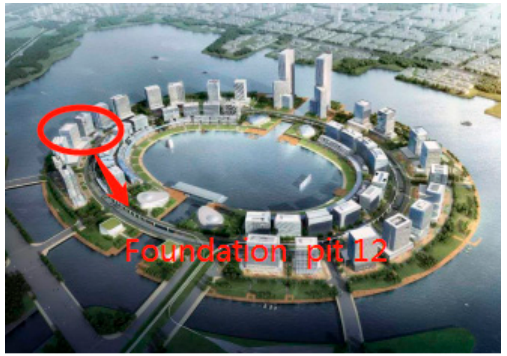
Figure 4. Beilong Lake Financial Island.